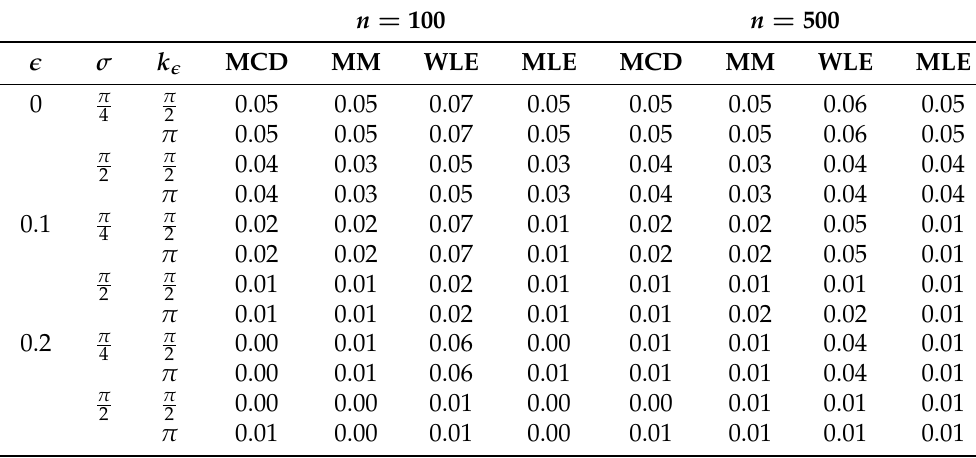
Table 1. Median values of type–I error rate for p = 2 and α = 5%.